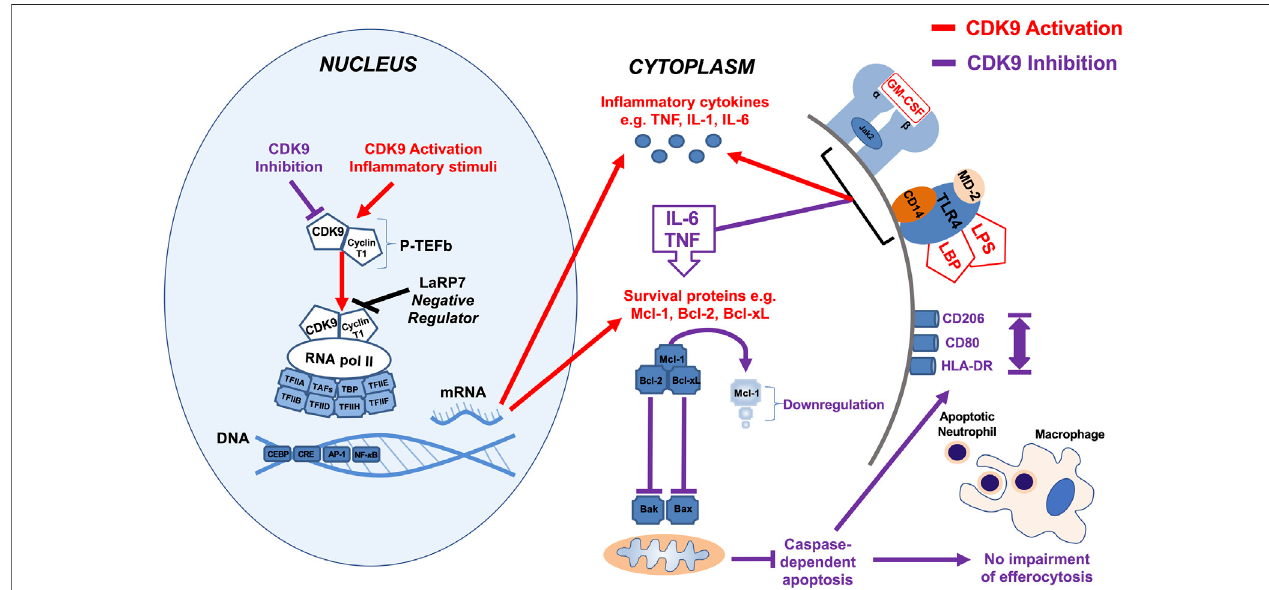
FIGURE 7 | Summary diagram of effects of CDK9 inhibition and activation on in fl ammatory pathways in monocyte-derived macrophages. Activation of CDK9 initiates binding with regulatory subunit cyclin T to form the heterodimeric complex P-TEFb, which in turn regulates transcription elongation via phosphorylation of RNA polIIandsubsequentmRNAsynthesisofanti-apoptoticproteinsandin fl ammatorycytokines.InhibitionofCDK9inMDMsdoesnotdrivecaspase-dependentapoptosis despite Mcl-1 downregulation, in contrast to its effects in neutrophils, as MDMs possess additional anti-apoptotic proteins such as Bcl-2 and Bcl-xL (Lucas et al., 2014). Inhibition of CDK9 can also reduce the release of potent in fl ammatory cytokines, including TNF, IL-6, and IL-1 β after MDM stimulation with LPS, but does not impair MDM efferocytosis of apoptotic neutrophils, nor does it polarize MDMs to a pro- or anti-in fl ammatory phenotypes, based on cell surface